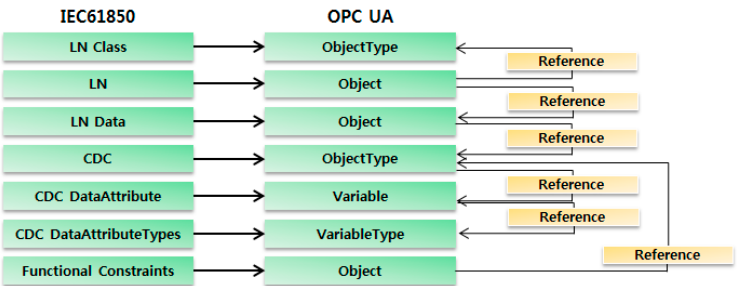
Figure 6. Mapping of the IEC 61850 information model onto OPC UA AddressSpace.